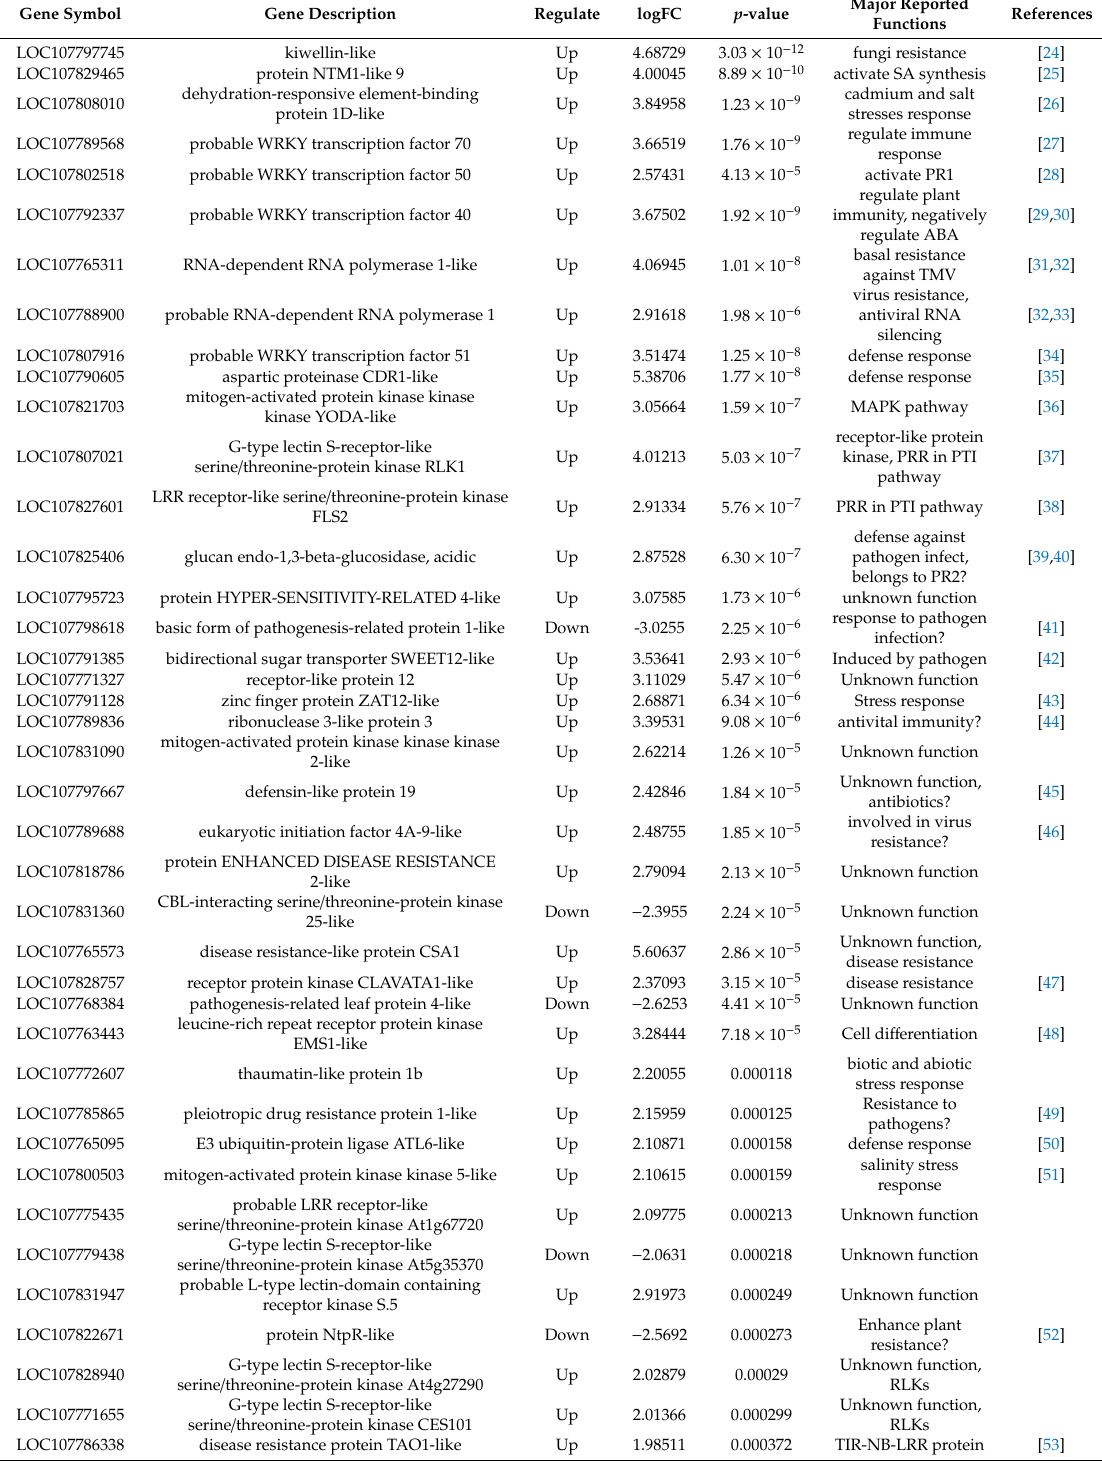
Table 2. Defense signaling responsive genes induced by